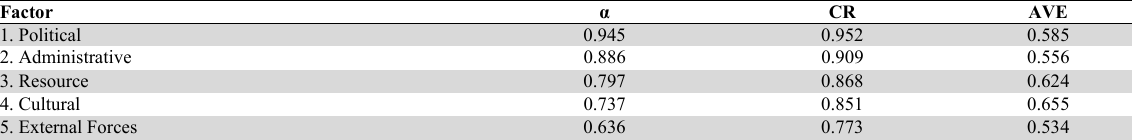
Convergence Validity